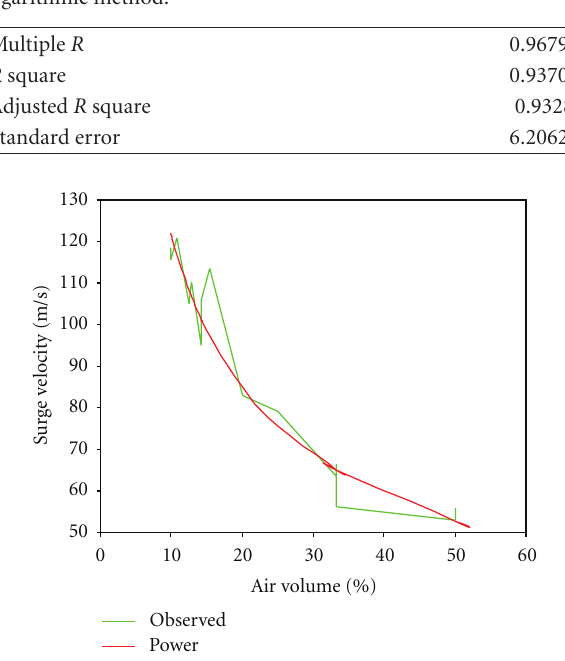
Figure 3: Power curve fit for surge wave speed of water pipeline with free water bubble.